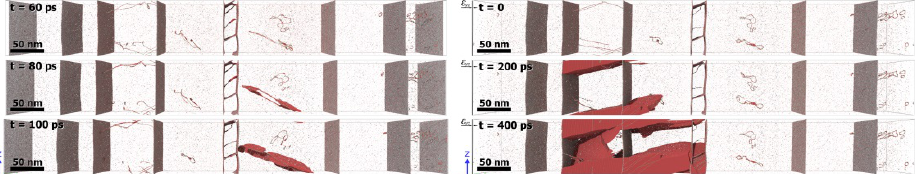
Fig. 4. Initial stages of metastable β phase destruction in a bamboo-like coarse grain sample after the passage of a plain shock wave of ~3 GPa and the following release wave in the sample (on the left) and under imposed shear deformation ε yz =0.02 (on the right). No bcc atoms are